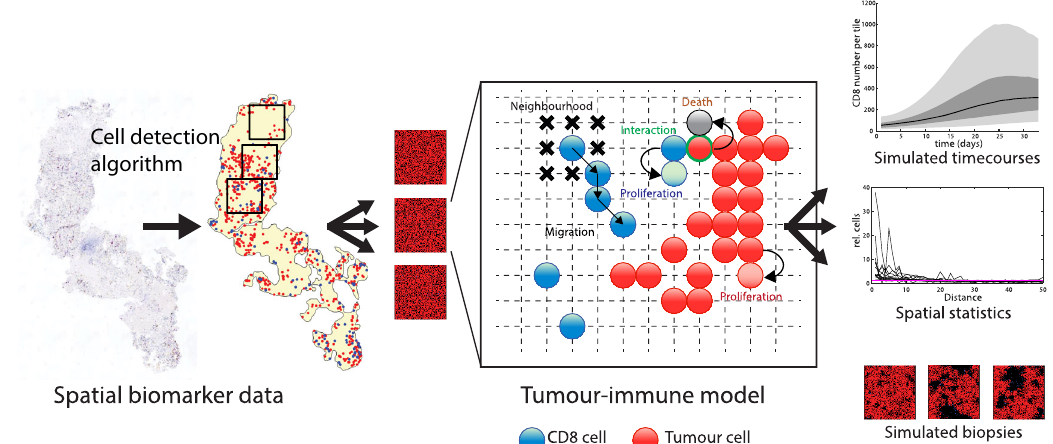
Fig. 1 Integrating digital pathology and mathematical modelling. For each patient sample, tissue sections of pre- and on-treatment biopsies were stained against CD8 and Ki67 and digitally analysed to extract the positions of CD8 cells and tumour cells. The image is subdivided into tiles which are used as an input to the model. In the agent-based model, cells at each grid site follow rules regarding their behaviours and interactions. The state of the model is recorded at each time step and the results can be visualised as timecourses and spatial summary statistics and simulated biopsy